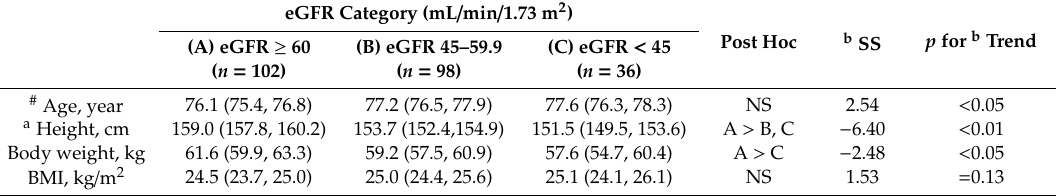
Table 2. Anthropometric characteristics, and trends, adjusted for age and sex, by eGFR categories.